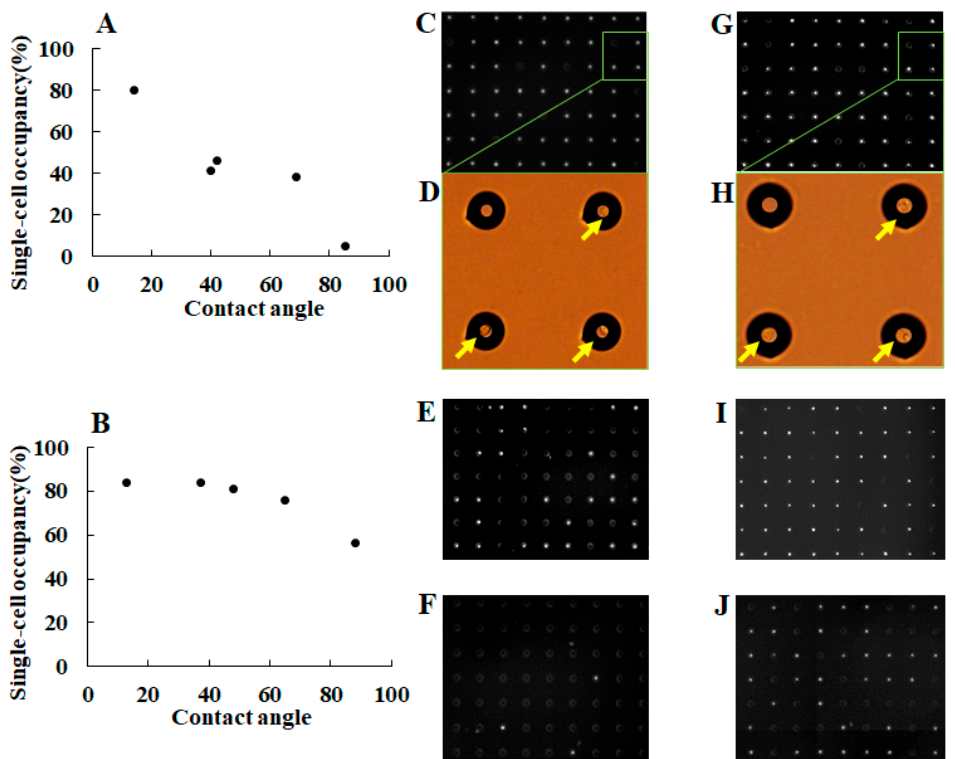
Figure 4. Optimization of single-cell occupancy on the microarray chip by surface treatment with plasma etching. Dot plots showing the condition of single-cell occupancy of ( A ) NCI-H1650 and ( B ) CCRF-CEM cells on a single-cell microarray chip with different levels of hydrophilicity (as determined by the contact angle of water). Fluorescence images of single-cell occupancy for ( C , E , F ) NCI-H1650 and ( G , I , J ) CCRF-CEM stained with DAPI at different condition of contact angle. Fluorescence images of single NCI-H1650 cells occupancy at the condition of ( C ) 14°, ( E ) 39°, and ( F ) 85° of contact angle. Fluorescence images of single CCRF-CEM cells occupancy at the condition of ( G ) 12°, ( I ) 37°, and ( J ) 88° of contact angle. Magnified pictures show light microscopic images of ( D ) NCI-H1650 and ( H ) CCRF-CEM cell confined in the microchambers. Arrows indicate single-cell confinement in the microchambers.